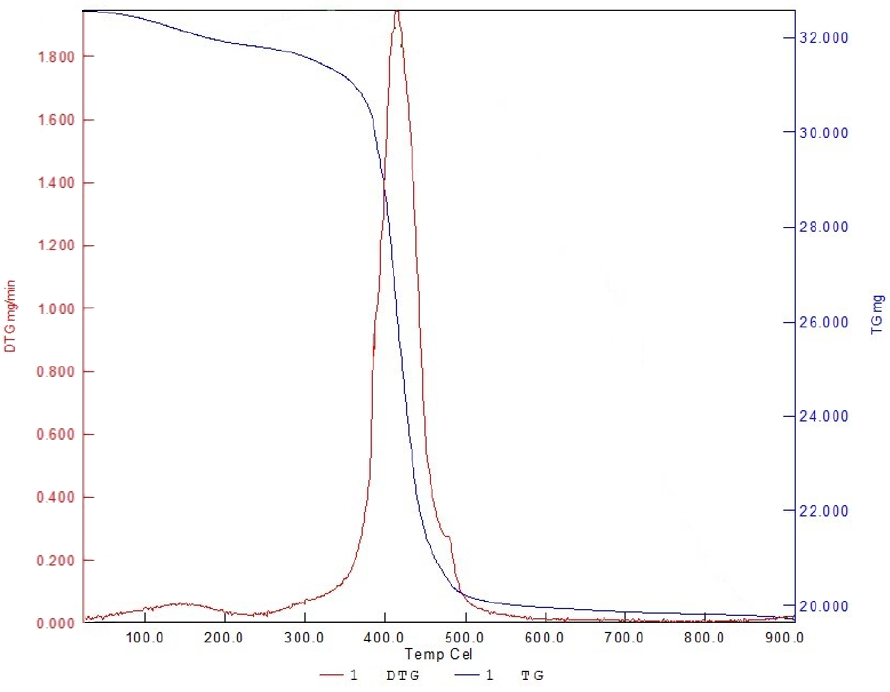
Figure 6. Result of thermogravical analysis.